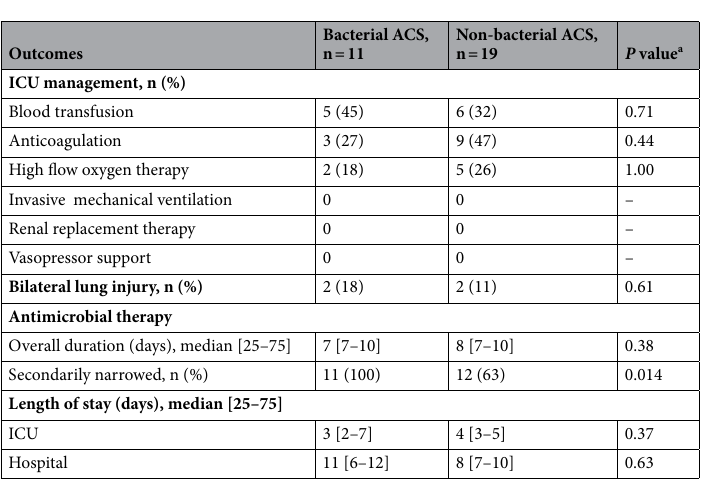
Table 3. Management and outcomes of the 30 patients with ACS and complete microbiological investigations. ICU: intensive care unit. a Results are reported as number (percentage) or median [inter-quartile range]. The corresponding between-groups comparisons were performed using the Fisher’s exact test and the Mann– Whitney test,